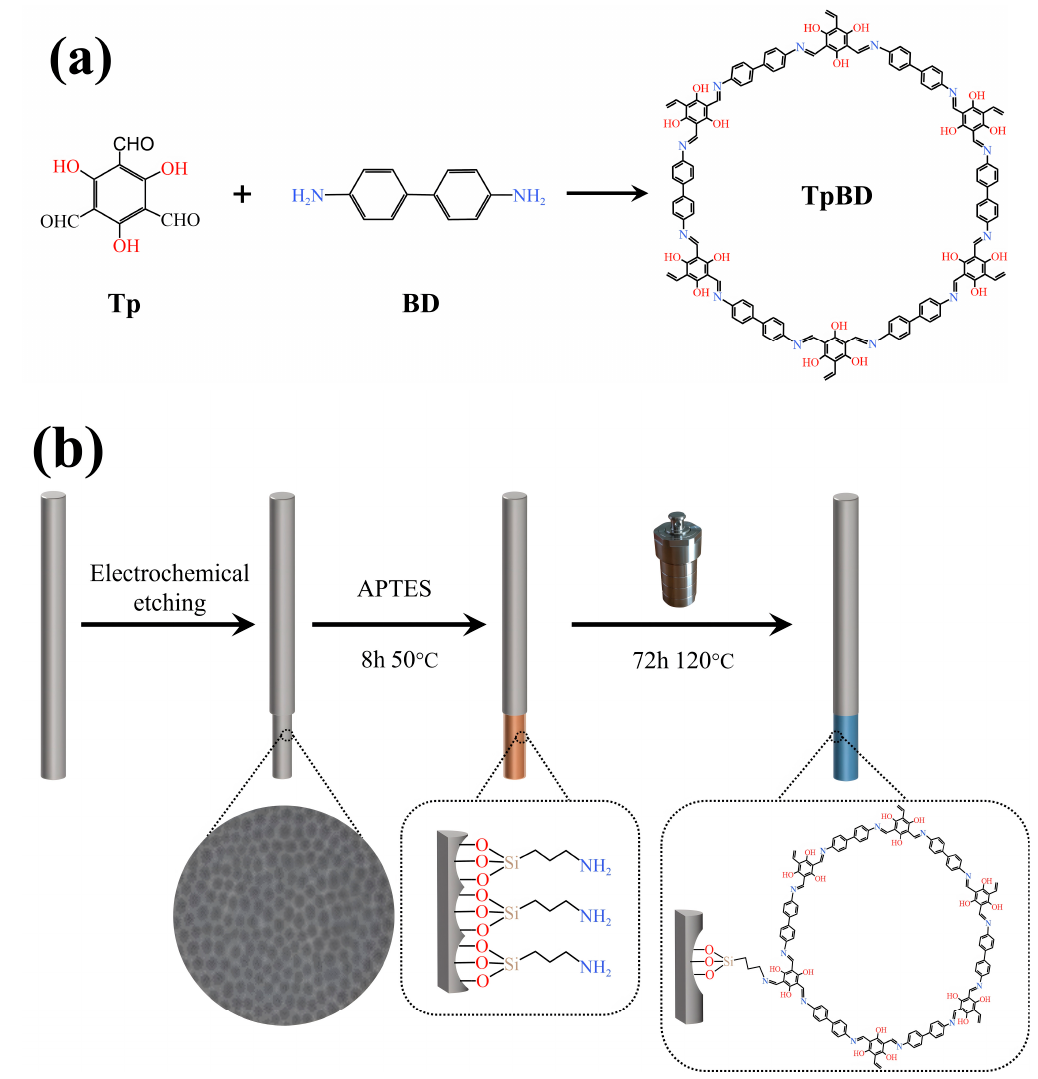
Figure 2. ( a ) Diagrammatic representation of the synthesis of TpBD by condensation of TP and BD. ( b ) Schematic illustration of the fabrication processes of COF ‐ TpBD ‐ bonded AN ‐ SSF.